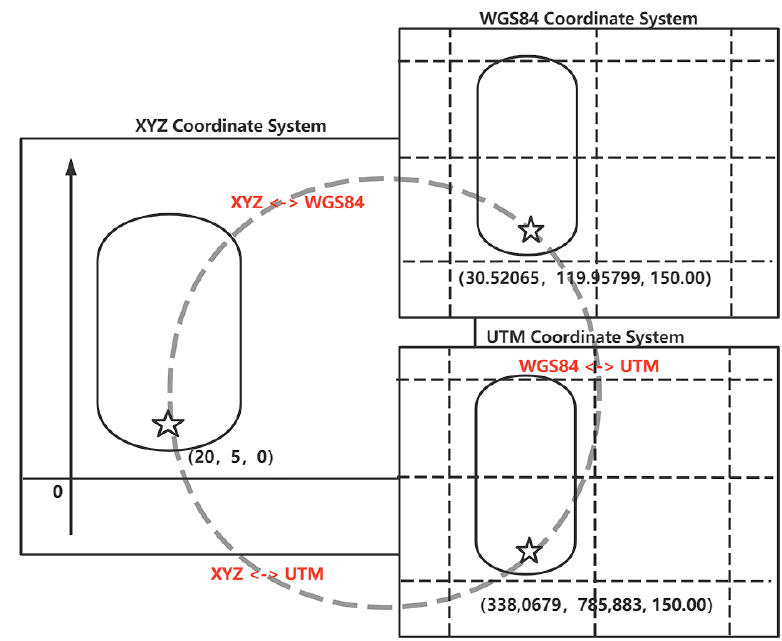
Figure 7. Transformation of coordinates, the star represents a point in the